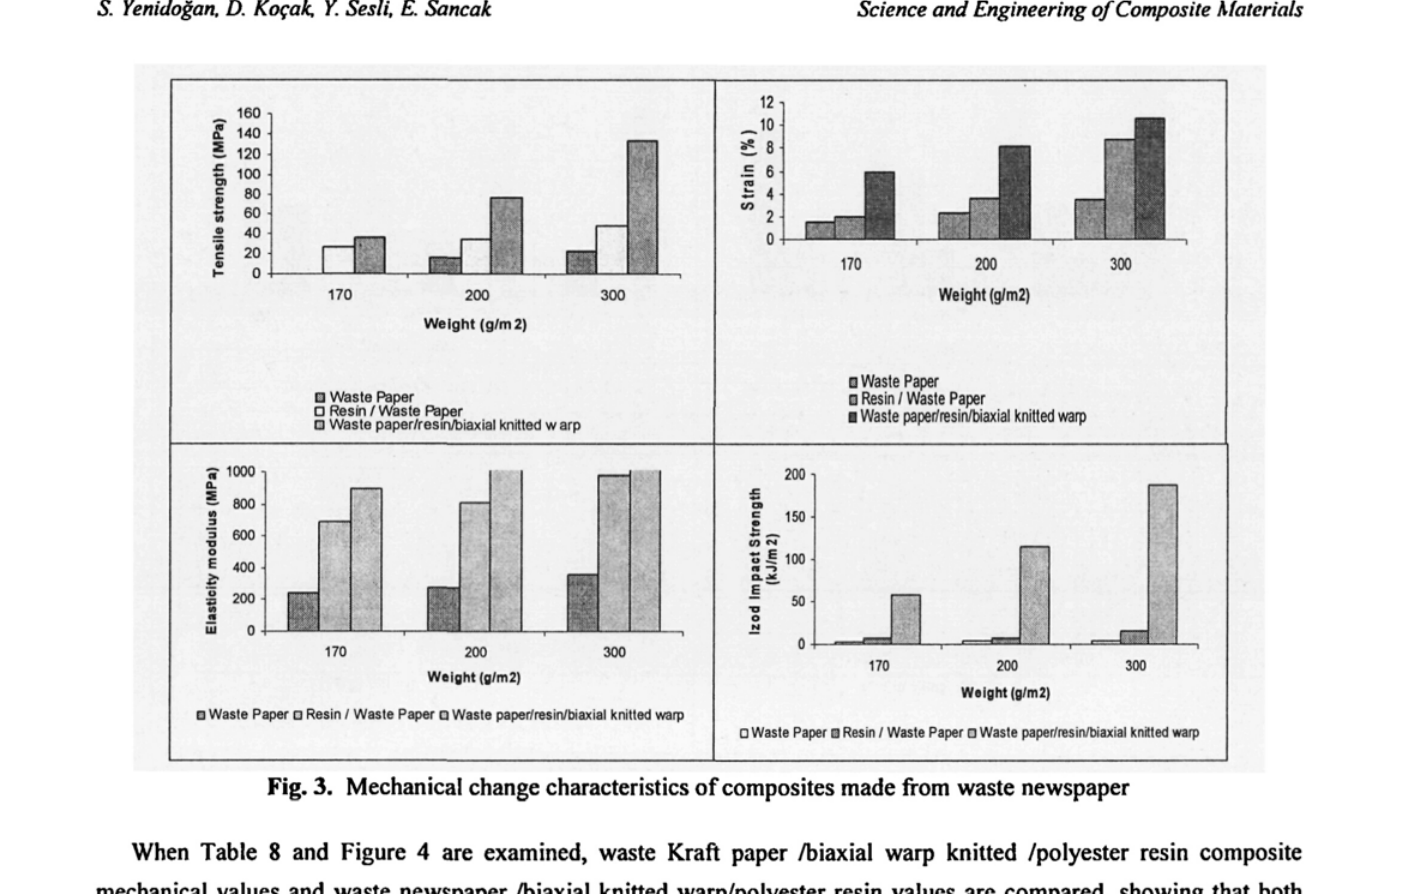
Fig. 3. Mechanical change characteristics of composites made from waste newspaper